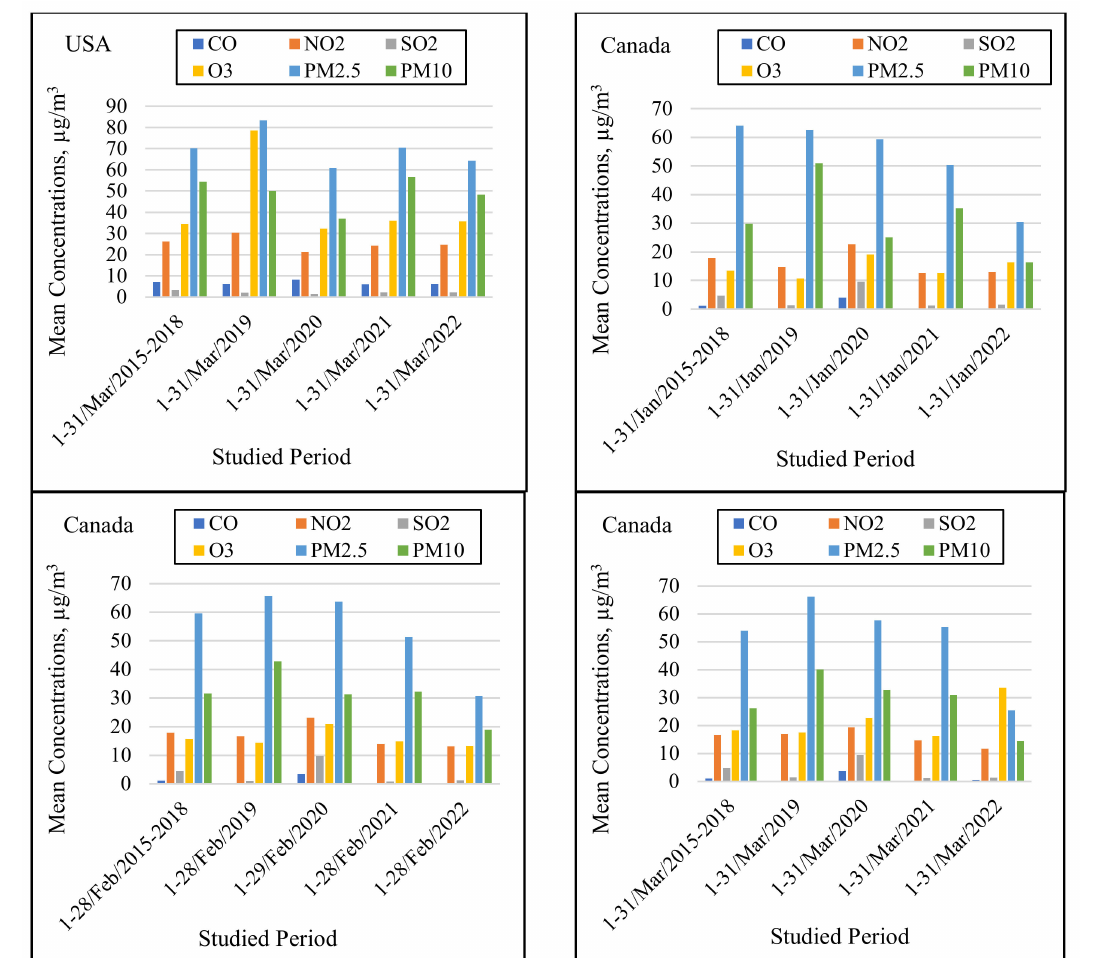
Figure 2. Average concentrations of air pollutant in countries of the North American geoeconomic